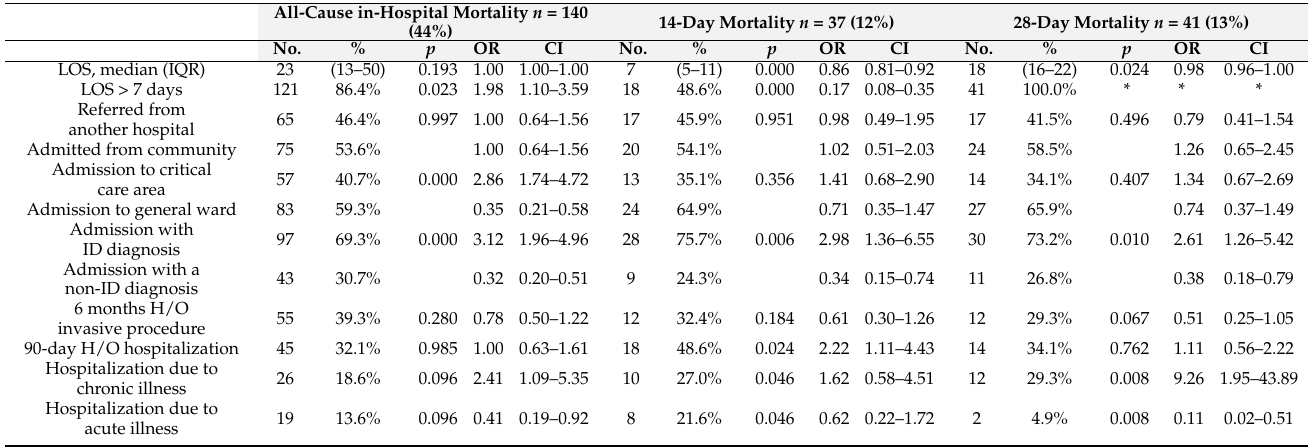
Table 2. Hospitalization details versus mortality rates (Binary logistic regression).